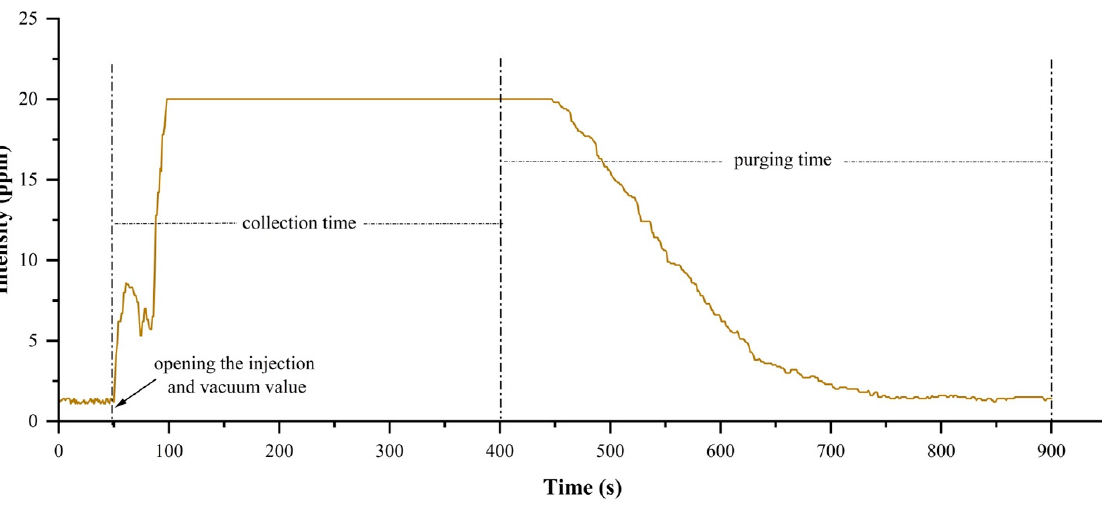
Figure 1. ( a ) The portable electronic nose; ( b ) schematic diagram of the portable electronic nose.